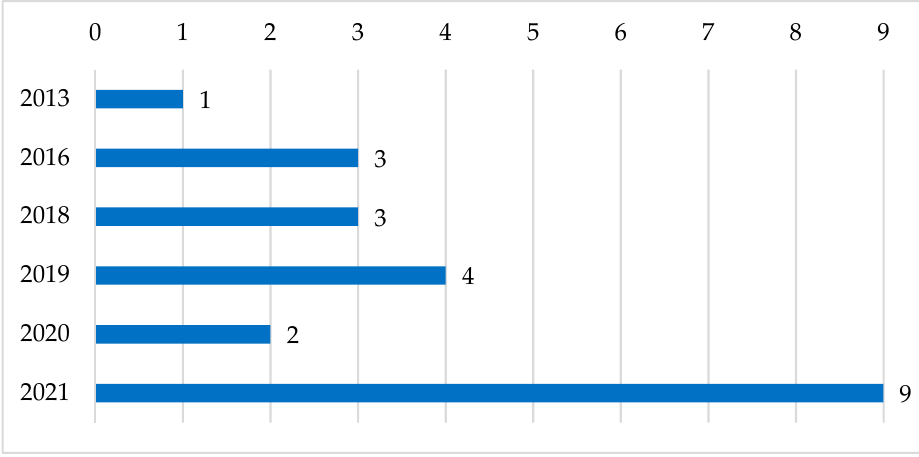
Figure 3. Articles distribution per year.